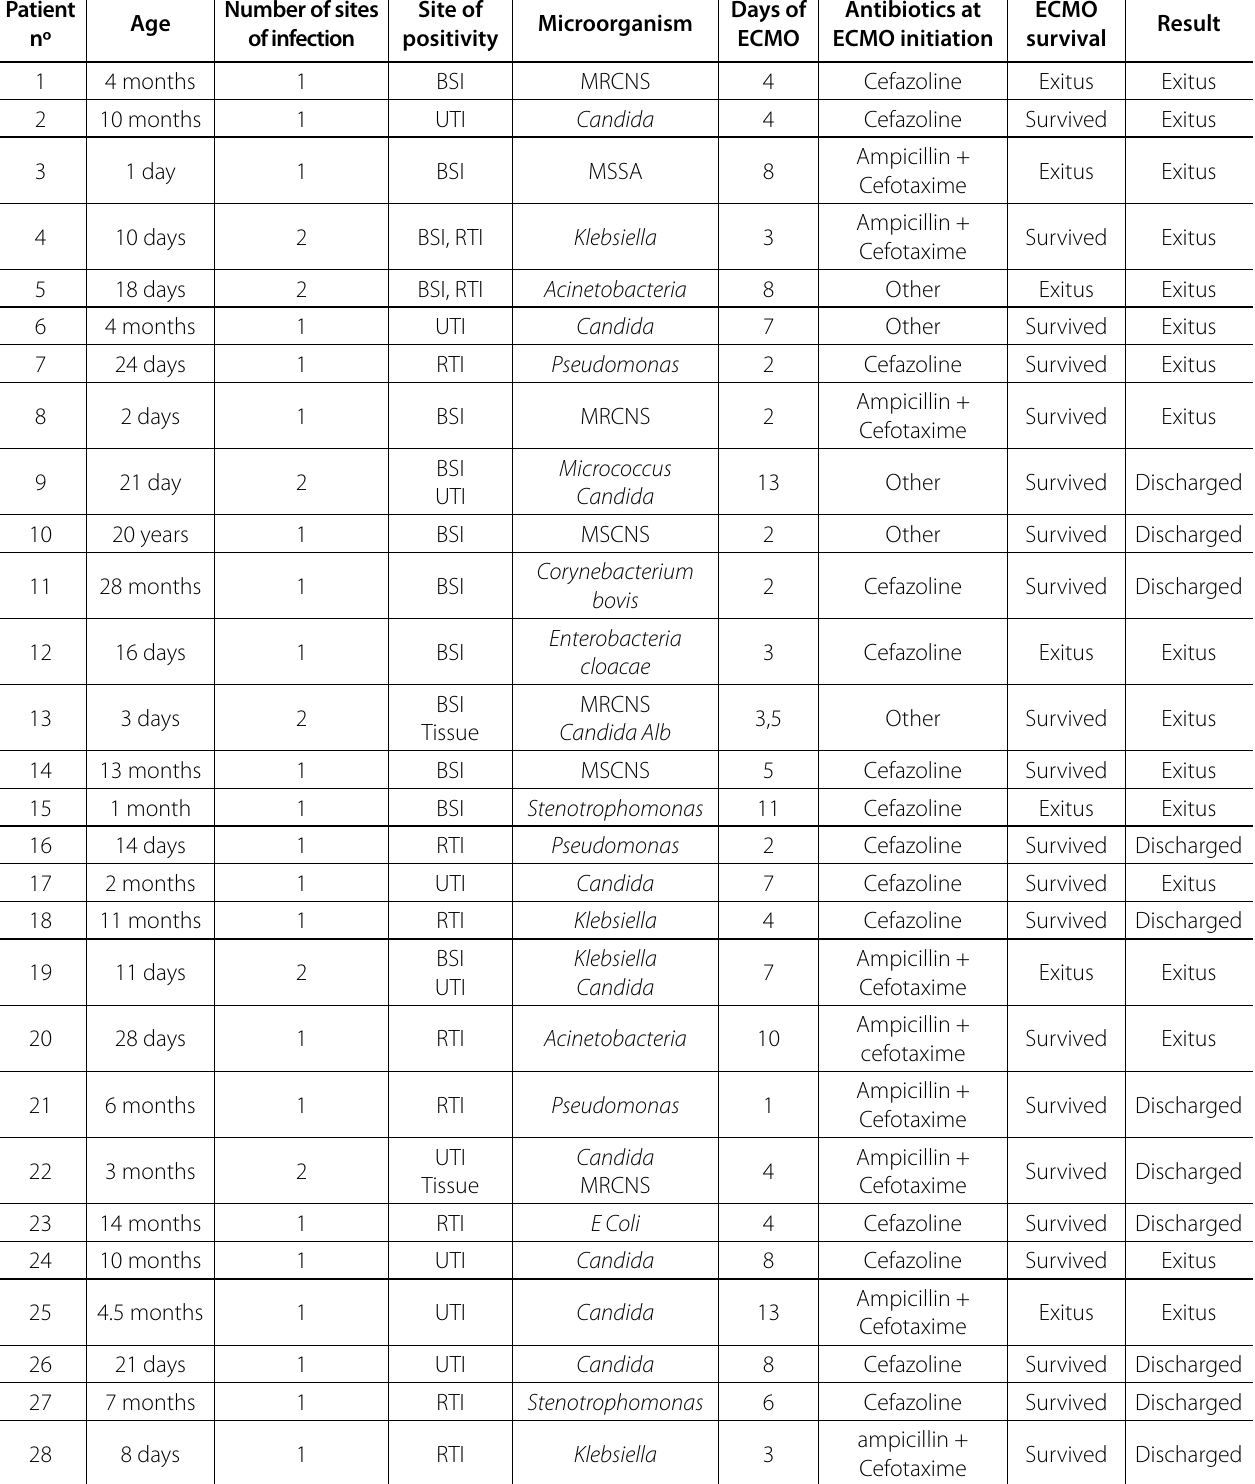
Table 2. The characteristics of patients who had culture positive nosocomial